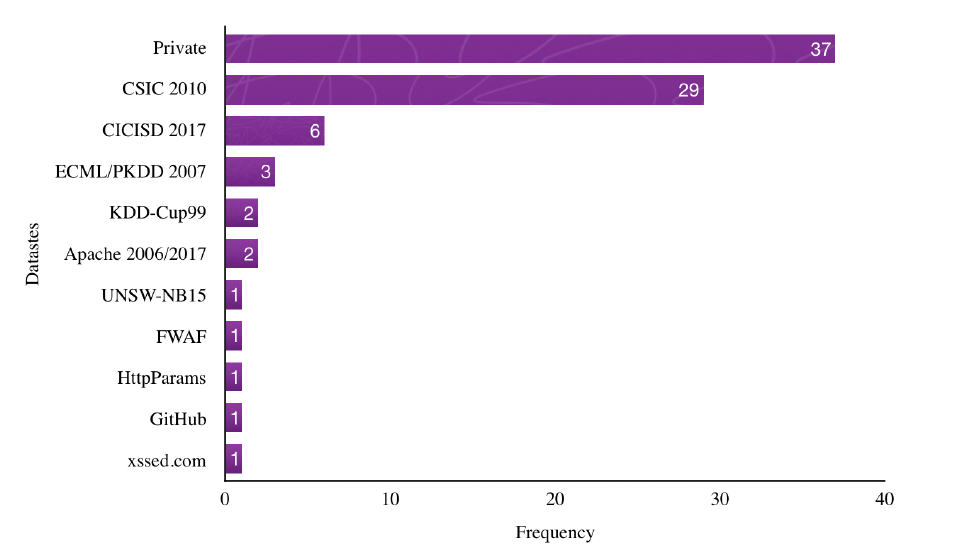
Figure 9. Histogram of datasets used in selected